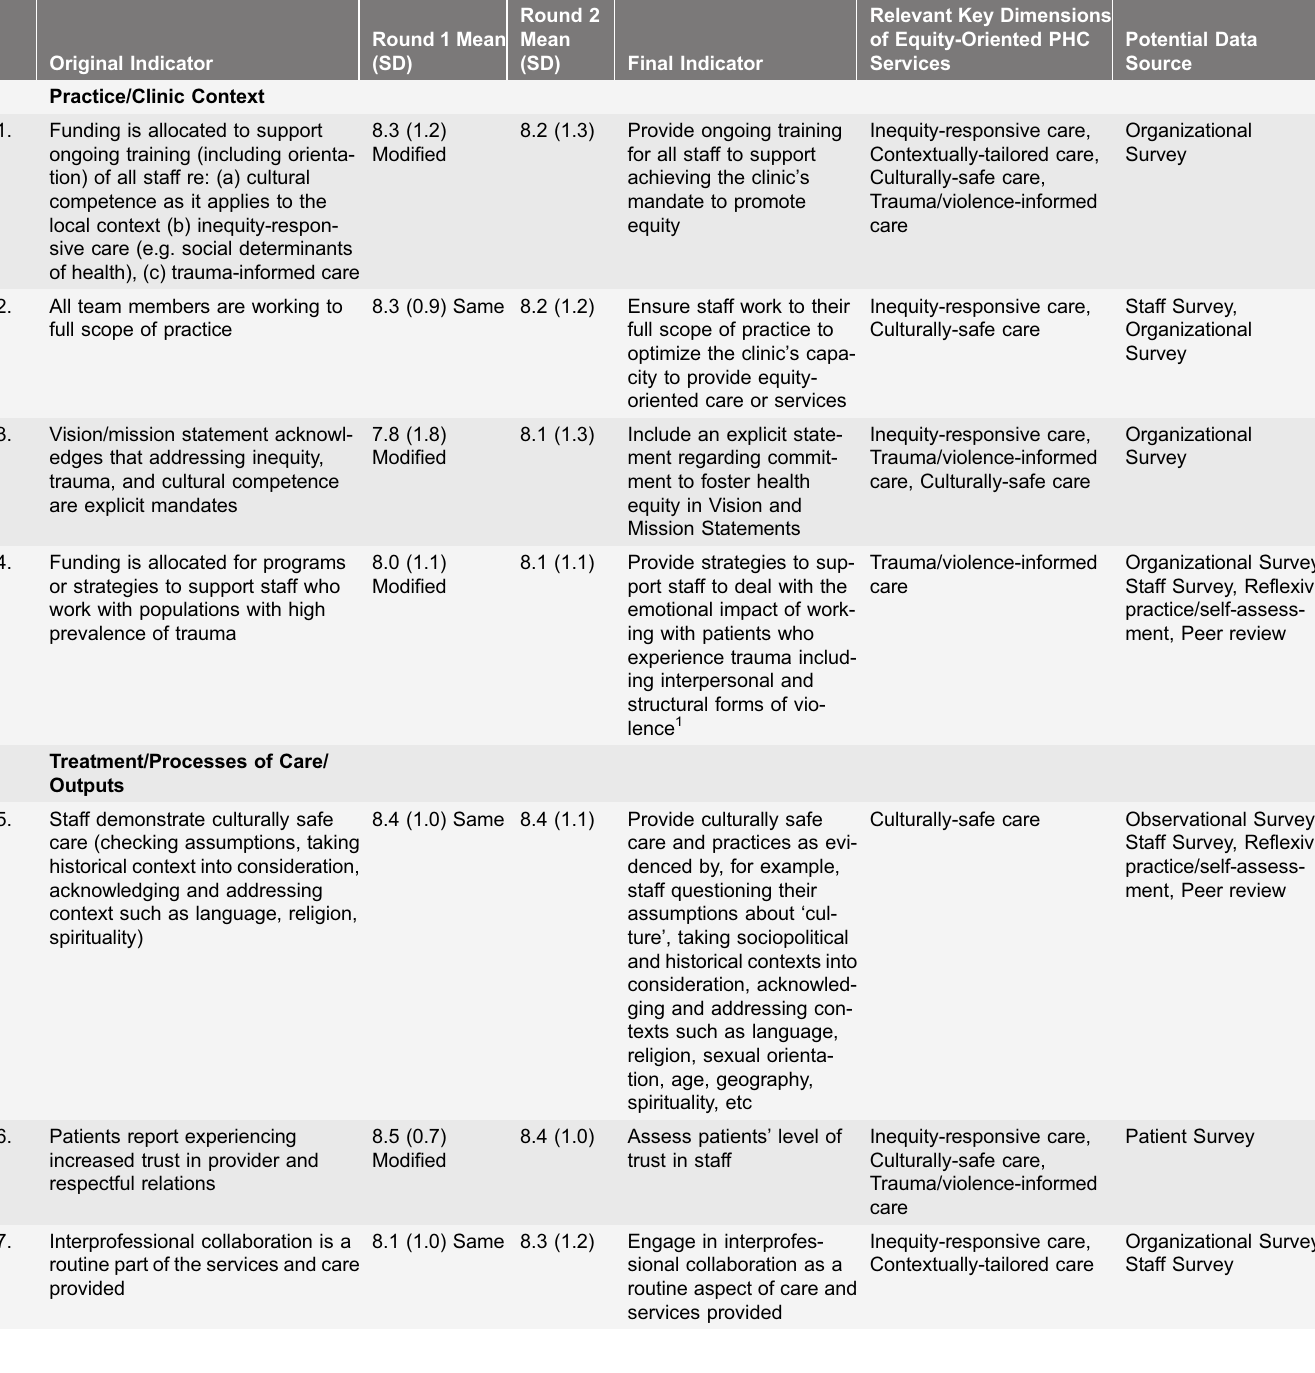
Table 1. Core set of Health Equity Indicators for PHC Organizations After Modified Delphi